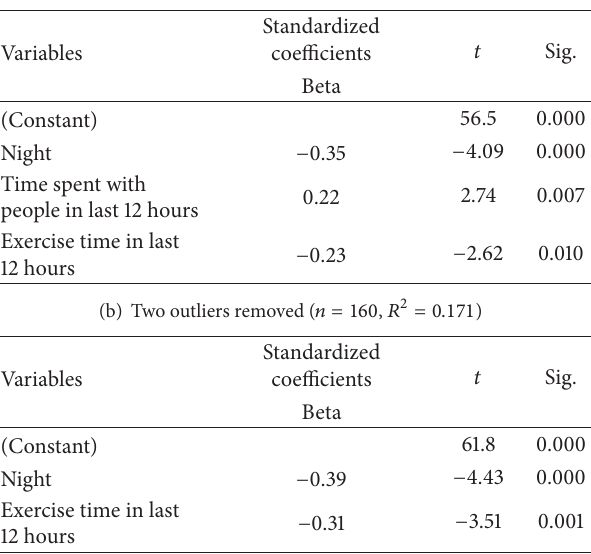
Table 3: Linear regression results for mean blood glucose calculated over 12-hour periods.